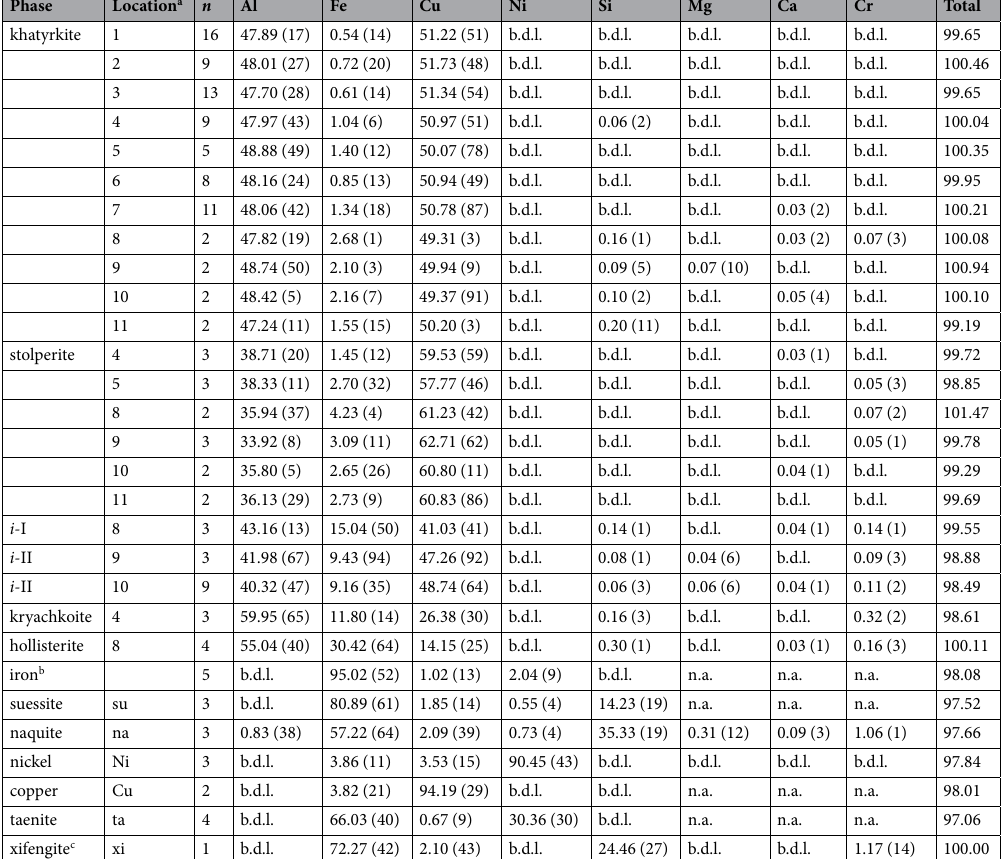
Table 1. Averaged elemental compositions of metal phases in 126A by EPMA-WDS. All in elemental weight %. n : number of analyses included in average, n.a.: not analyzed, b.d.l.: below detection limits, 0.07 wt% Al, 0.2% Ni, 0.05% Si, 0.04% Mg, 0.03% Ca, 0.05% Cr; SEM-EDS detection limit ~0.1 wt%. Uncertainty given in parentheses represents one standard deviation from the mean based on all analyses [e.g., 50.3 (13) = 50.3 + / − 1.3]. a Location refers to Fig. 2a. b Iron composition is averaged over multiple iron beads. c Xifengite analyzed by SEM-EDS (normalized total to